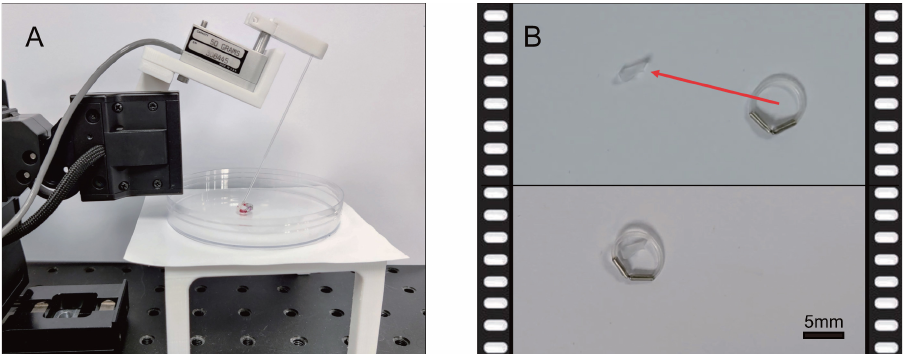
Figure 13. Illustration of re-configurable function and microforce measurement of a circular MHCMM. ( A ) Experimental setup of microforce measurement; ( B ) once the robot reaches the specified position, the hypothetical tumor (heteromorph) nesting is